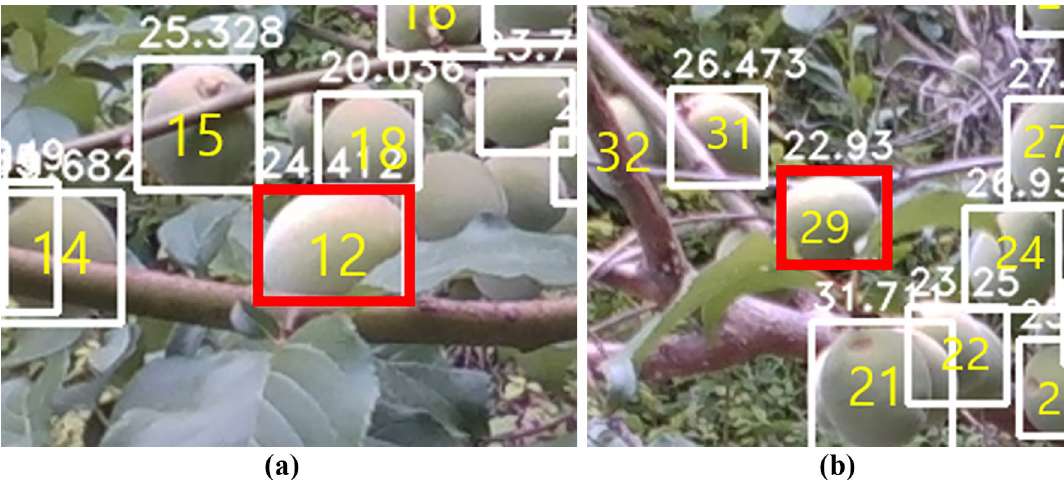
Figure 6. Case of losing growth information of some prunus mume fruits (Number 12 and 29) due to adjacent fruits or surrounding